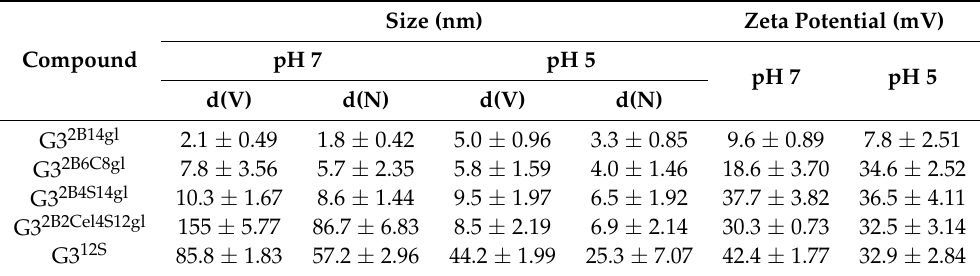
Table 1. Size of conjugates averaged by volume (d(V)) and by number of molecules (d(N)) and zeta potential values ± standard deviation determined by DLS